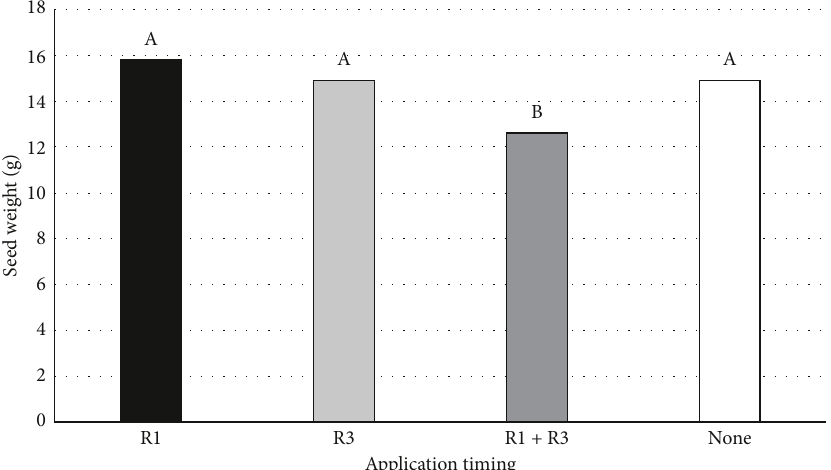
Figure 5:100-seed weight of harvested soybean according to the main effect of application timing for the fertilizer experiment conducted in Fayetteville, AR, in 2019 and 2020. Treatments with the same uppercase letter are not significantly different according to Fisher’s protected least significant difference α 0.05. (cid:29)